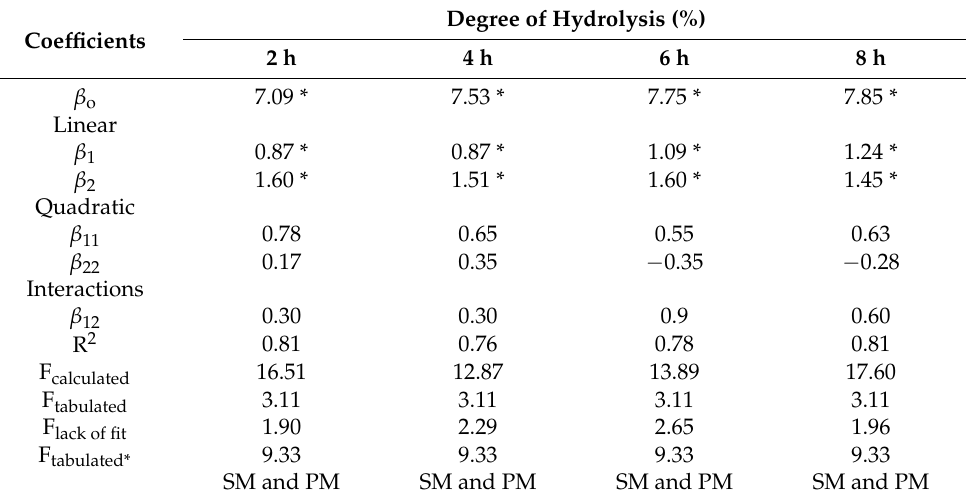
Table 6. Sequential hydrolysis composed of ultrasound and enzymatic steps—regression coefficients and analysis of variance (ANOVA) for response